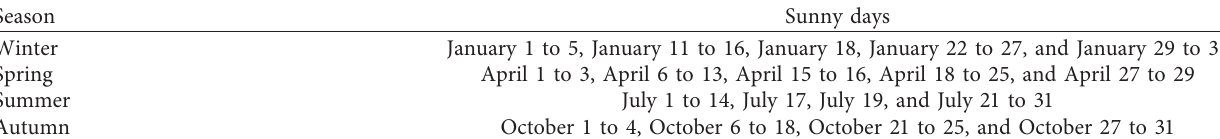
Table 1: The sunny days of the four seasons in 2017.